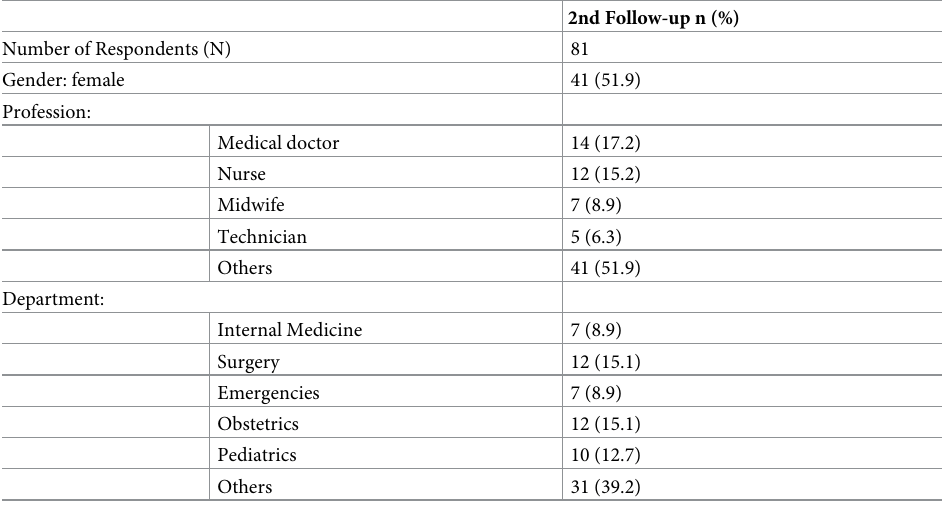
Table 1. Study population of quantitative research.